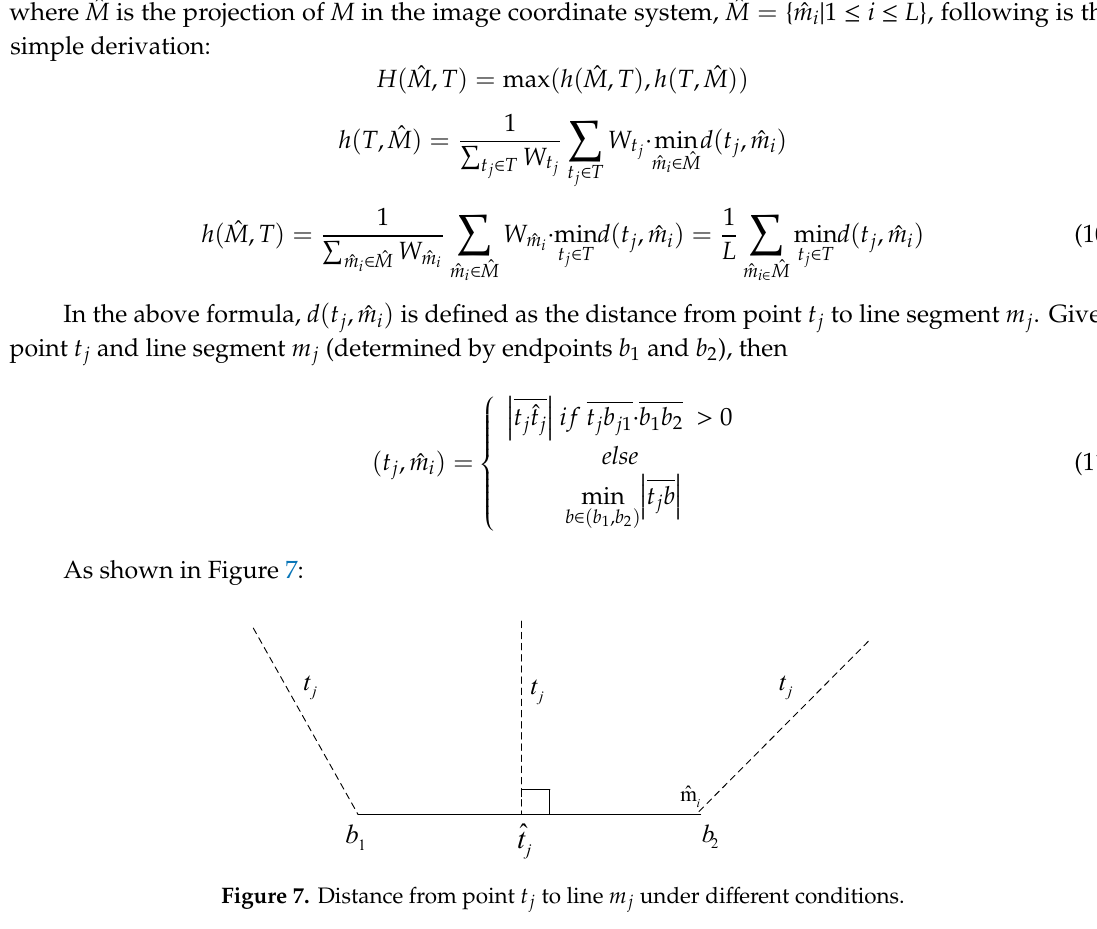
to line 𝑚 under different conditions (cid:3037) (cid:3037)